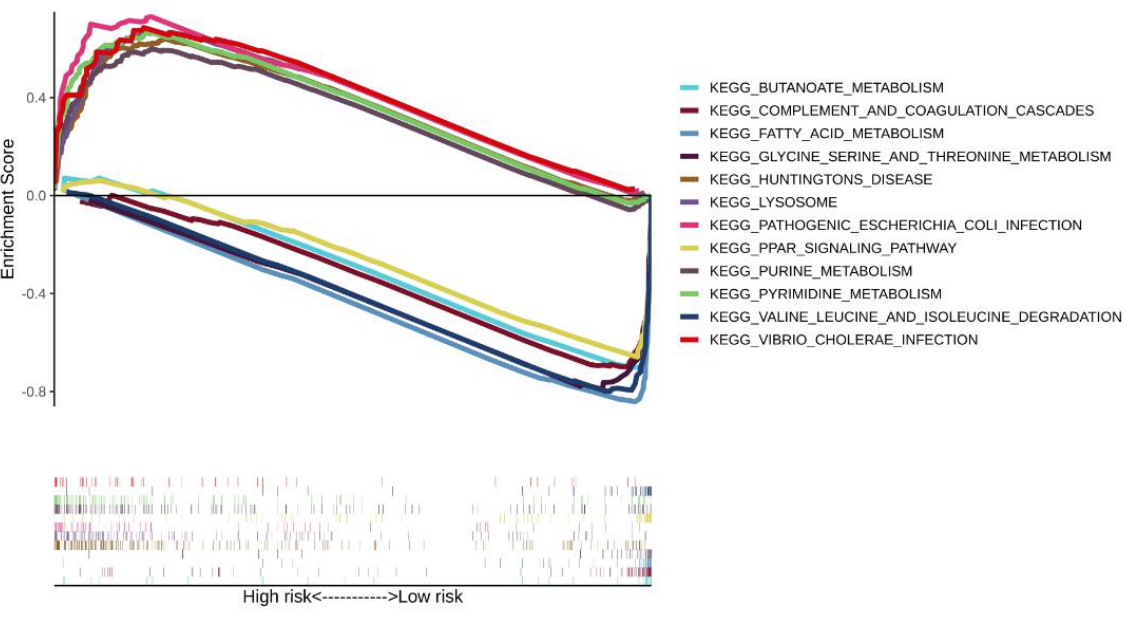
Figure 8. Comparison of enriched signaling pathways between the risk subgroups of the TCGA-LIHC dataset.